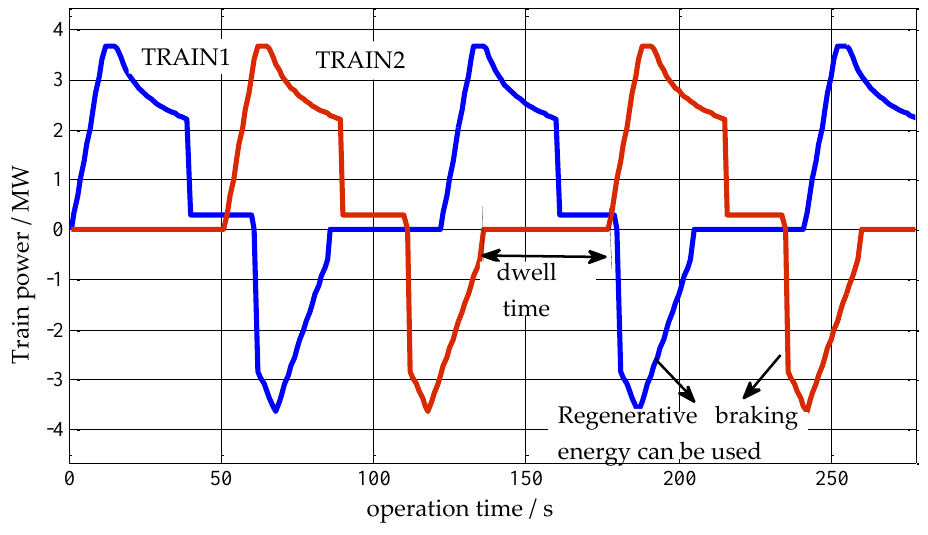
Figure 4. Train power curves before dwell time modification.